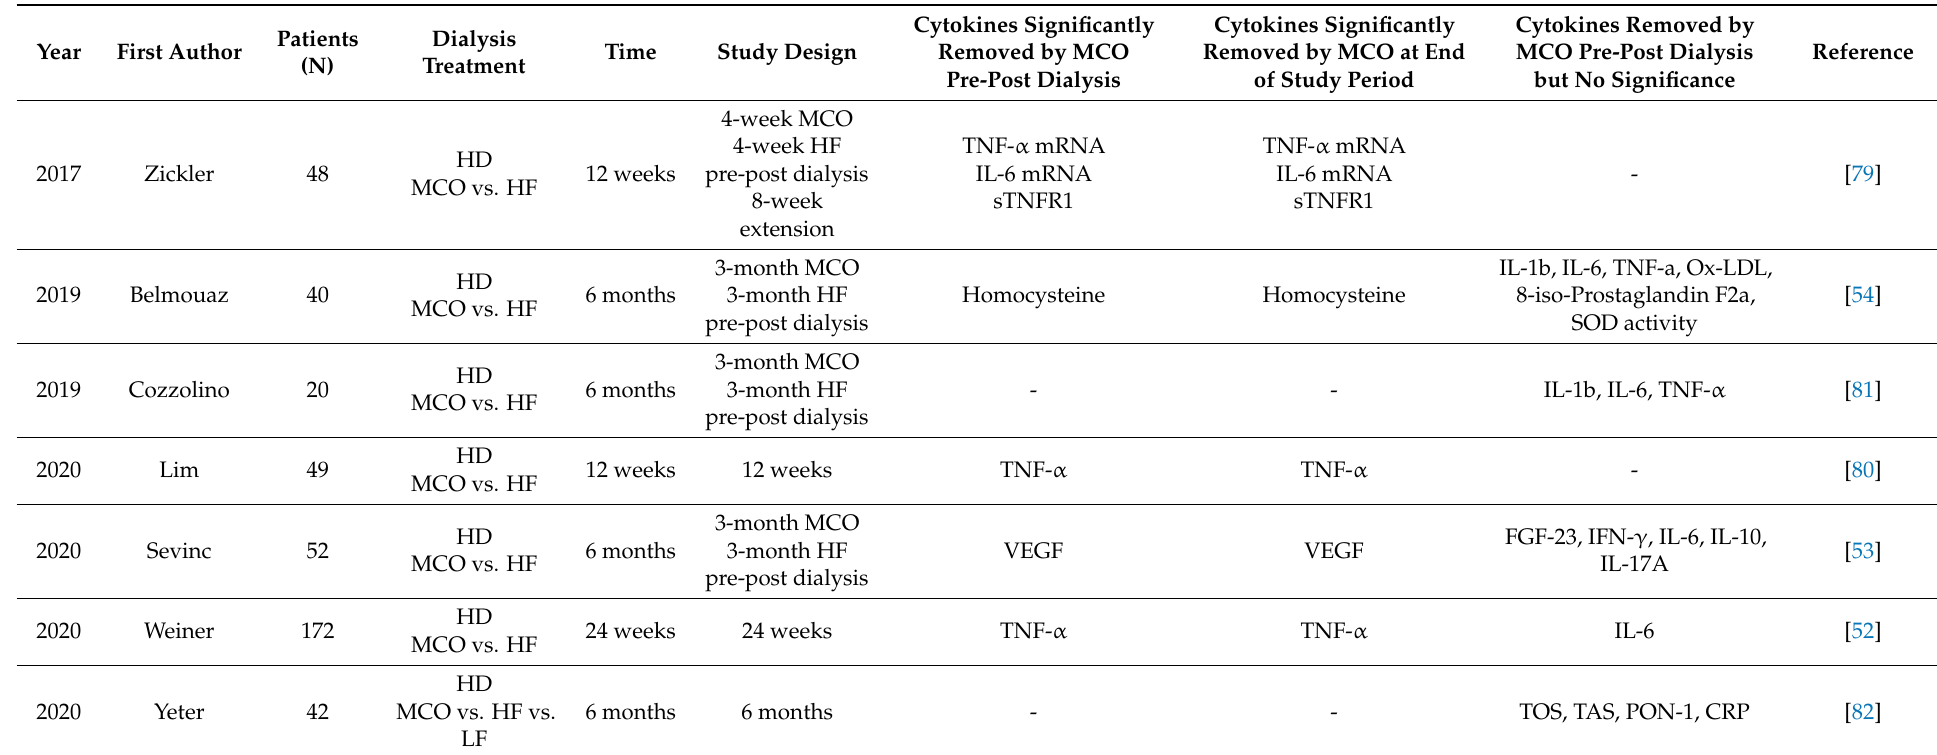
Table 3. Effect of MCO membranes on micro-inflammatory status and oxidative